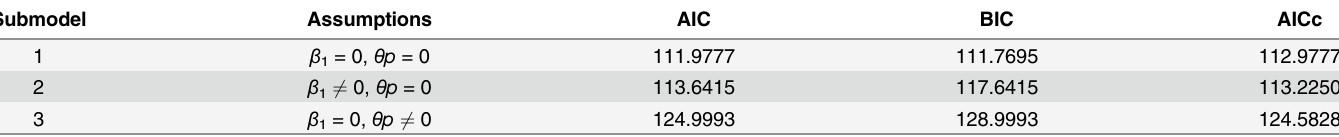
= 18725. The other initial conditions are assumed to be S (0) = 3000000, A (0) = 30000, C (0) = 1960000 and R (0) = 9000000 respectively. (cid:129) The parameter β is obtained by fitting the model to data. By the least-square estimation, the 2 transmission coefficient is estimated as β = 0.08078 and the 95% bootstrap confidence inter- 2 is (0.07229,0.09025). val of β 2